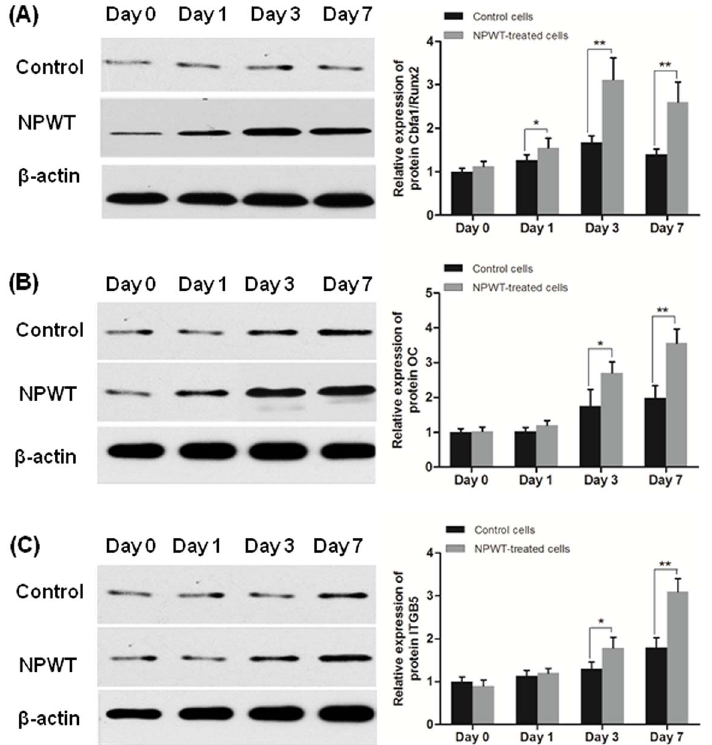
Figure 7. Western-blot assay. Protein expression levels of osteogenic factors in P-MSCs treated with NPWT at different time points were shown in (A) and (B). (A) Cbfa1/Runx2 was statistically overexpressed at day 1 after treatment with NPWT, with the increase being more significant after day 3. (B) Compared with control group, the expression of OC was markedly upregulated in NPWT group after day 3. ITGB5 protein level was shown in (C), it was not affected at day 1, but was strikingly upregulated after day 3 in NPWT group. (* p , 0.05, ** p , 0.01).